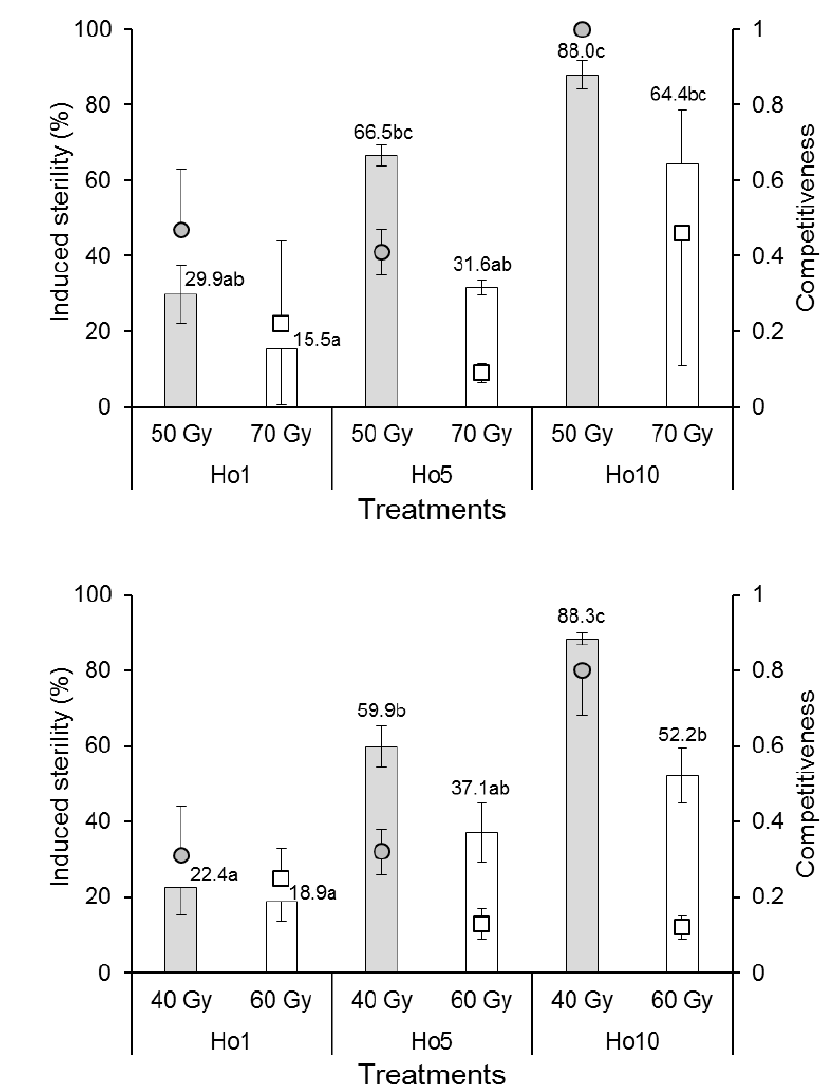
Figure 4. Mean male sexual competitiveness index values (circular and square points) and mean percentage induced sterility of eggs (columns) for ( A ) Aedes aegypti and ( B ) Aedes albopictus females that mated in field cages with males that had been exposed to one of two doses of radiation in the pupal stage. Controls included only fertile males (Hn) and only irradiated males (Hs). Values above columns indicate mean percentages of egg sterility. Means followed by identical letters did not differ significantly for comparisons among mating treatments and doses (ANOVA, Tukey p > 0.05). Vertical bars indicate the standard error. For clarity, only half the error bar is shown in some cases.